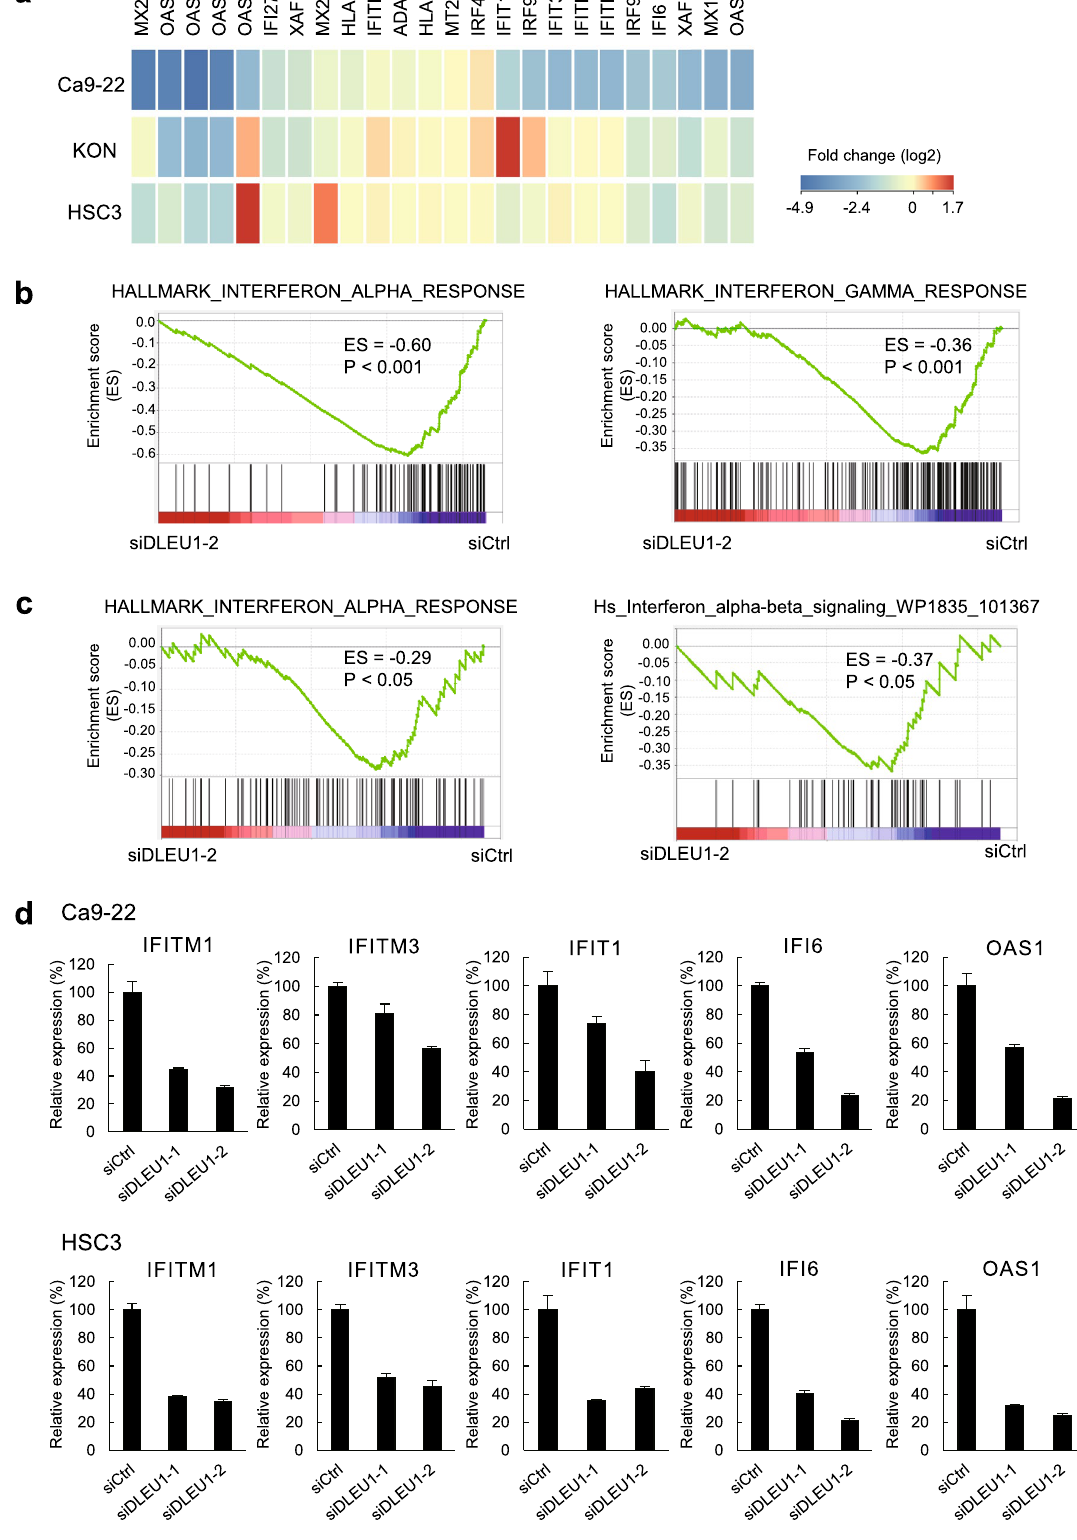
Figure 2. Suppression of interferon signaling-related genes in OSCC cells with DLEU1 knockdown. ( a ) Heatmaps showing microarray results of interferon signaling-related genes in OSCC cell lines with DLEU1 knockdown. Results are normalized to cells transfected with control siRNA. ( b , c ) Results of GSEA of the indicated gene sets in Ca9-22 ( b ) and HSC3 ( c ) cells with DLEU1 knockdown. ( d ) Results of qRT-PCR analysis of the indicated ISGs in Ca9-22 (upper) and HSC3 (lower) cells transfected with the indicated